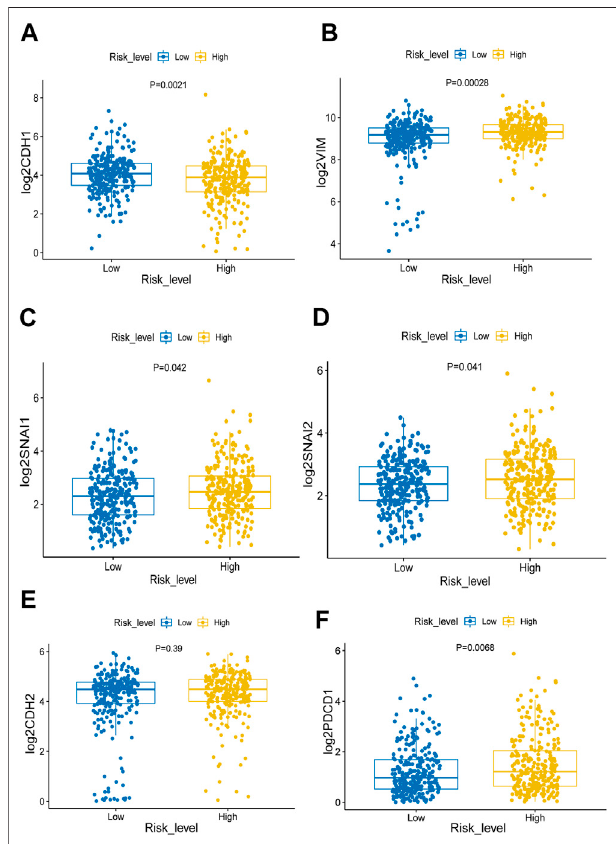
FIGURE 7 | Analyzing association with EMT and PDCD1 for m6AlRsPI subgroups. (A) The expression level of CDH1 in high m6AlRsPI group was decreased as compared with the low m6AlRsPI group. (B – E) Genes correlated with mesenchyme in high m6AlRsPI group were upregulated expression. (F) The expression level of PDCD1 was upregulated in high m6AlRsPI.